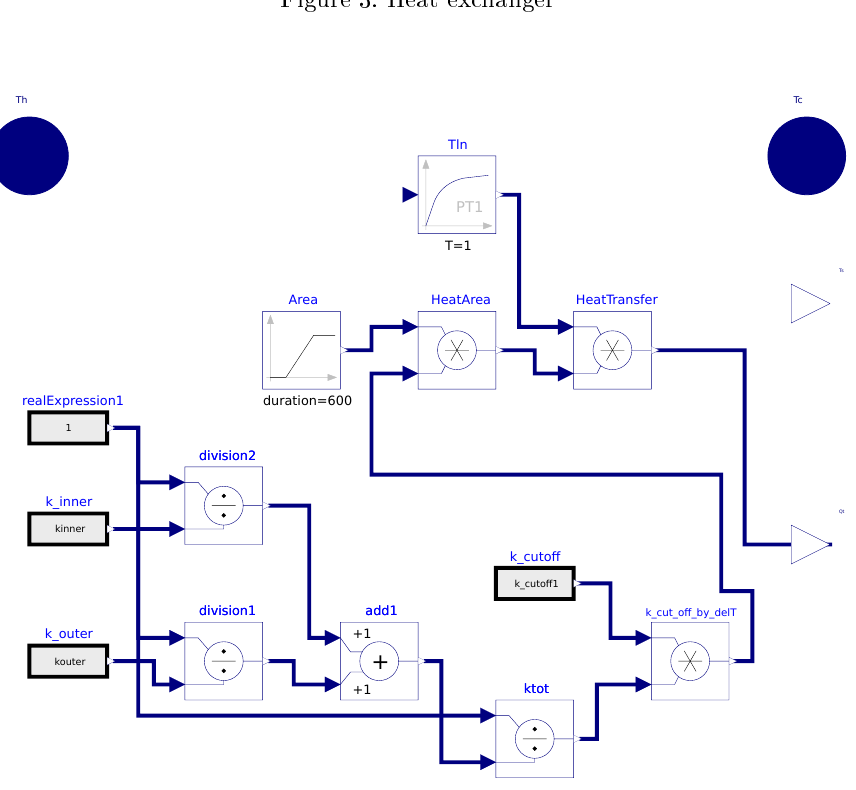
Figure 3: Heat exchanger